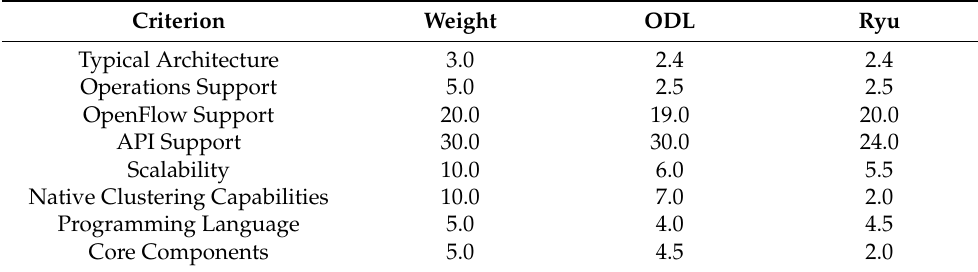
Table 4. Evaluation criteria between ODL and